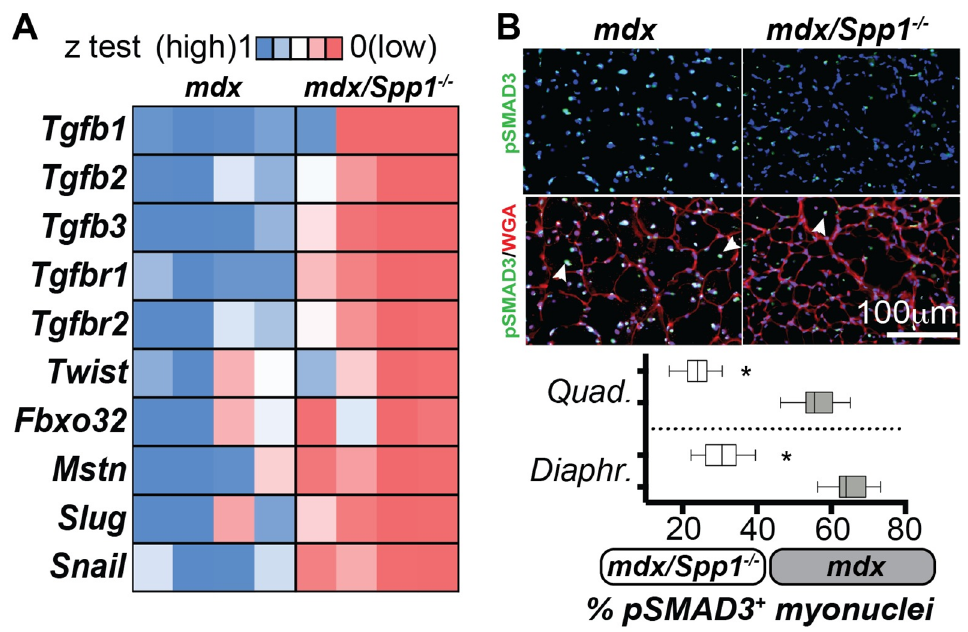
Fig 4. Spp1 ablation in mdx muscle is associated with decreasedTGF β gene expression and signaling. A) Heat-mapof qPCR analysisof geneexpression, normalizedto control muscles, showeddownregulation of genesassociatedwith the TGF β pathwayand atrophic remodeling in mdx / Spp1 -/- dystrophicmuscle ( tibialis anterior ).All genes shown in the heatmap were significantly different ( * ). B) Percentageof phosphorylated- Smad3-positive nuclei within myofibers (myonuclei; arrowheads) was significantly decreased in quadriceps (representative immunofluorescencepanels)and diaphragm muscles of mdx/Spp1 -/- mice when comparedto mdx mice. Box plots, Tukey distribution; heat-map,z-test averagevalues of fold change to control (ctrl); n = 4 mice/group; * , P < 0.05 vs mdx control, 1way ANOVA + Bonferroni.